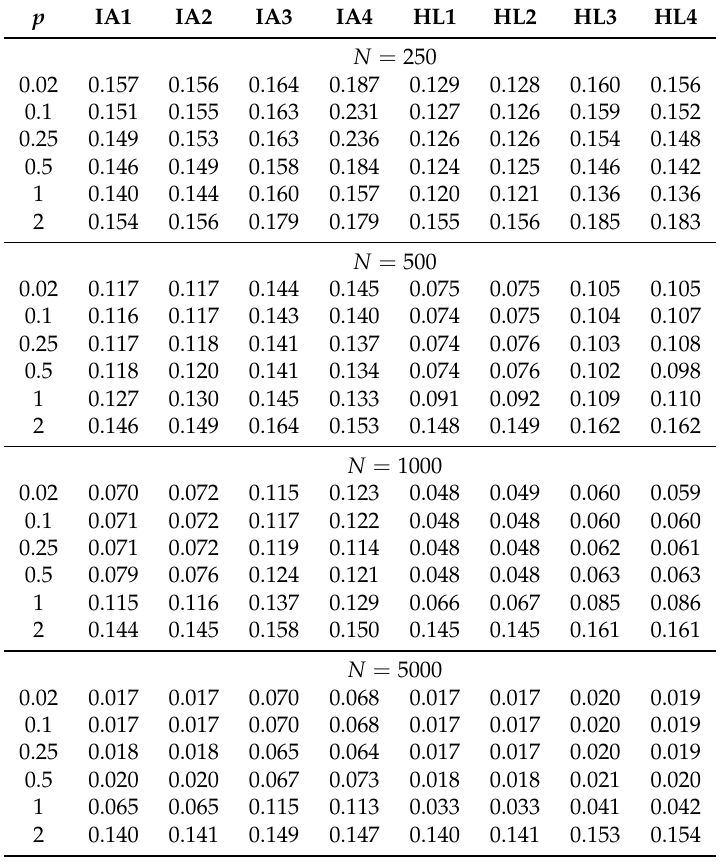
Table 4. Simulation Study 2: Average Root Mean Square Error (ARMSE) of Group Means as a Function of Sample Size in the Condition of Differential Item Functioning (DIF) and G = 6